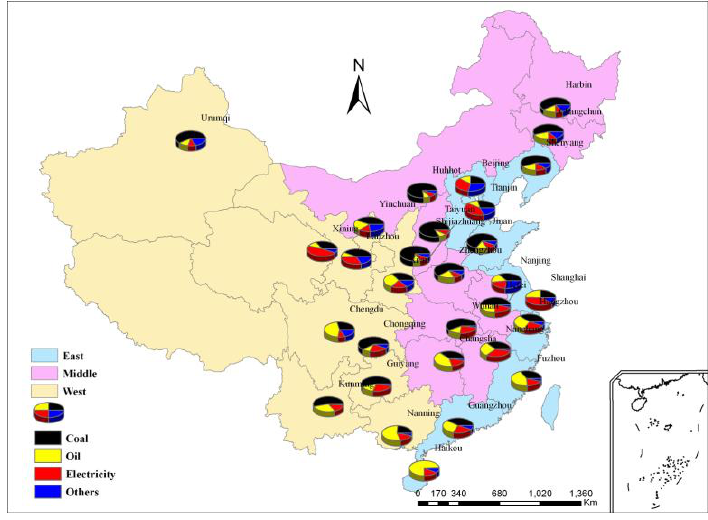
Figure 5. Energy mix for the 30 provincial capital cities of mainland China in